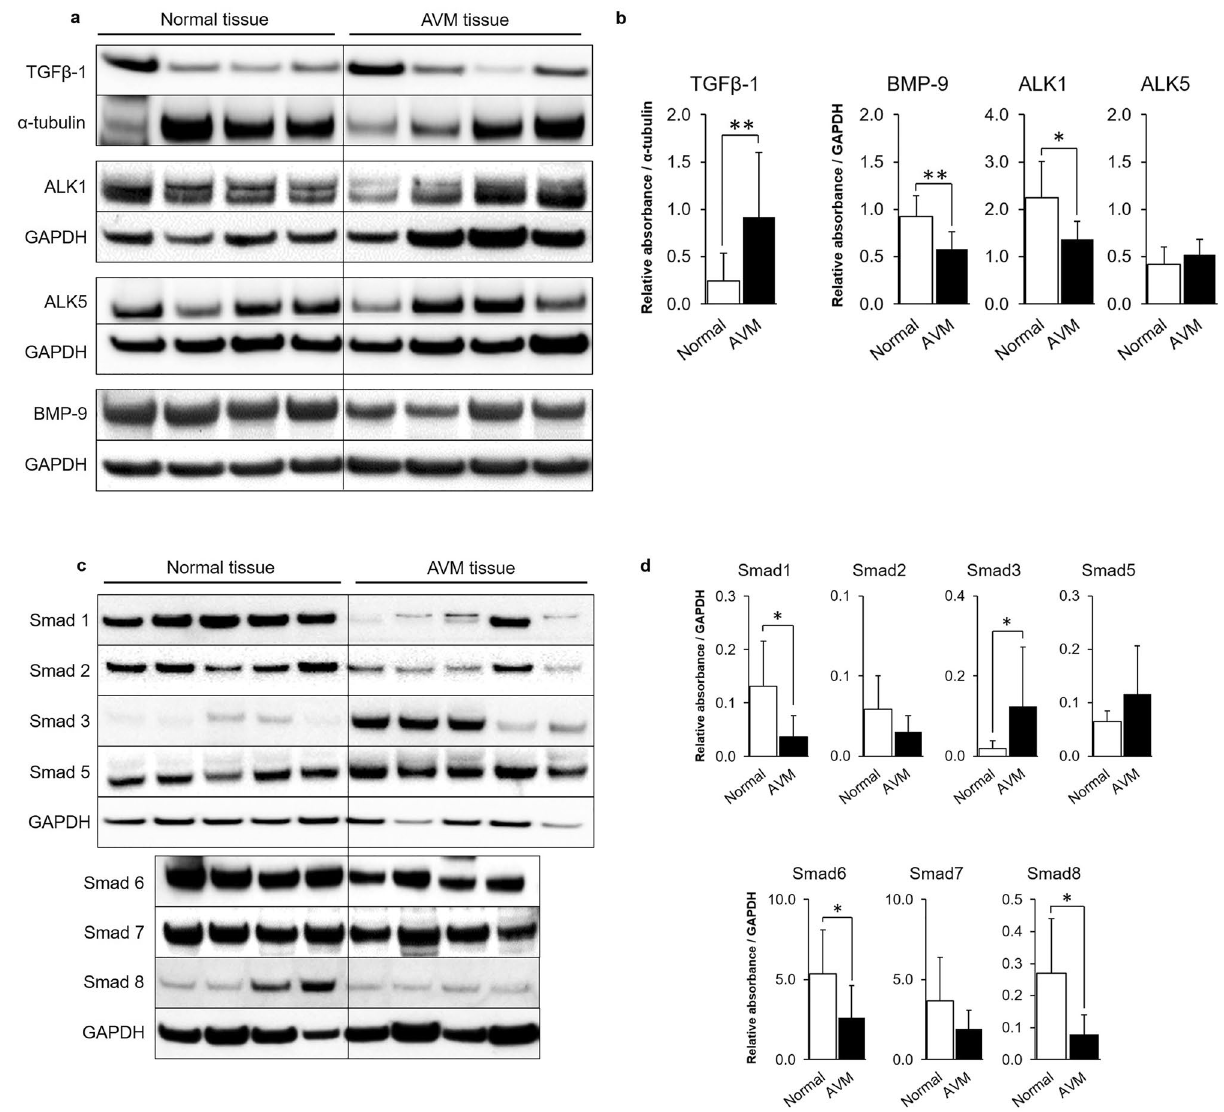
Figure 2. Expression of TGF-β/BMP pathway component proteins are dysregulated in AVM tissue. Protein levels of TGF-β1, ALK1, ALK5, and BMP-9 ( a ) and of Smad1–8 ( c ) were analyzed by western blot from AVM tissue samples (n = 10 patients) and normal tissue samples (n = 10 patients). Representative examples from each group are illustrated. GAPDH and α-tubulin protein expression were determined as loading controls. The total density of each protein band (n = 10 AVM and n = 10 normal) was determined using an ImageQuant developer and software, and relative expression was calculated by normalizing to loading controls ( b,d ). Error bars represent standard deviation. Paired t tests were performed to determine statistical significance (asterisks: *P < 0.05, **P < 0.01, ***P <